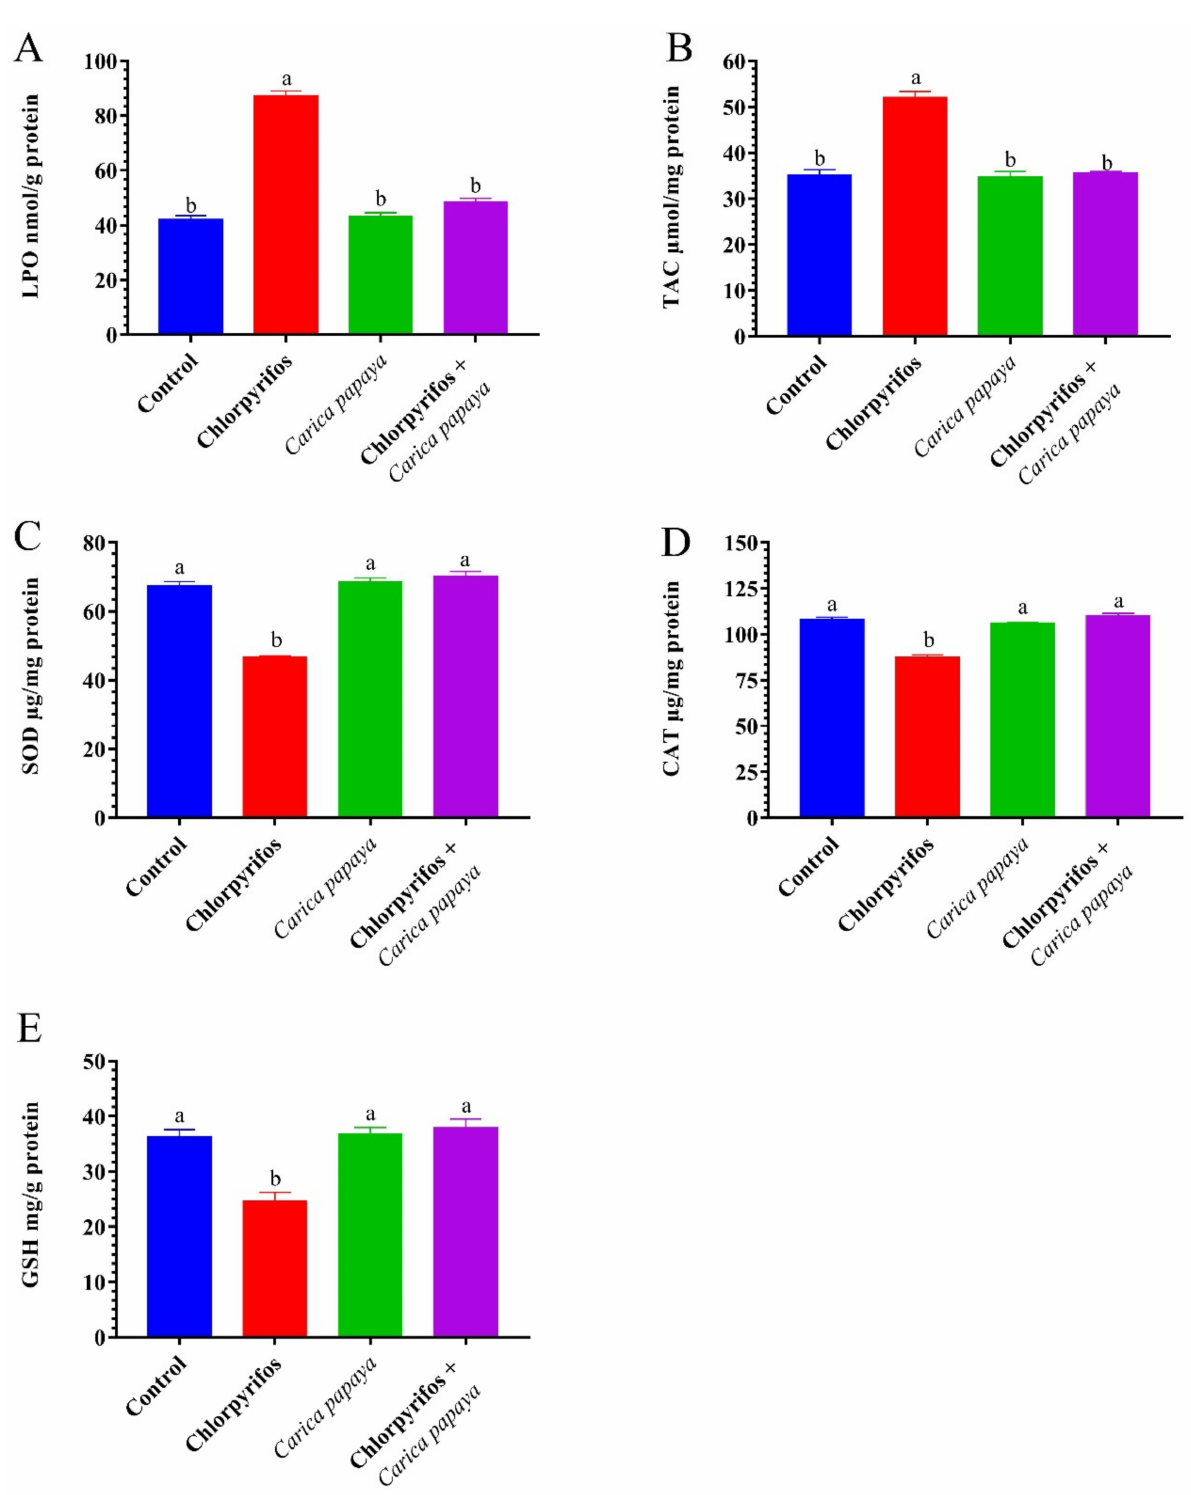
Figure 2. Lipid peroxidation ( A ), total antioxidant capacity ( B ), superoxide dismutase ( C ), total antioxidant capacity ( D ), catalase ( D ), and reduced glutathione ( E ) of renal tissue in female African catfish, Clarias gariepinus , exposed to chlorpyrifos (8.75 µ g/L) and co-administrated with papaya, Carica papaya , aqueous extract (250 mg/kg body weight) for 6 weeks. The column bearing with different letters are significantly different ( p <